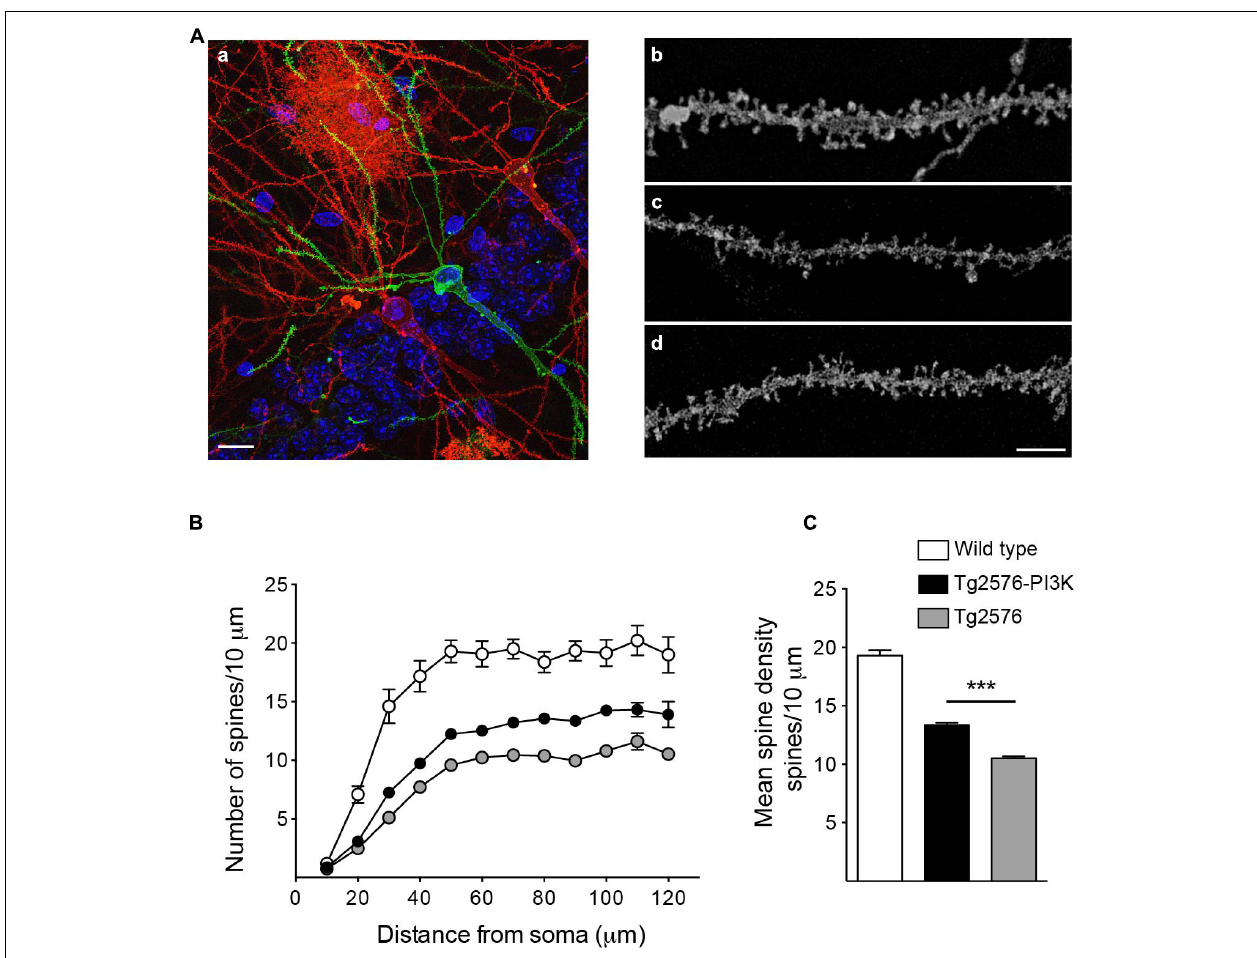
FIGURE 9 | PI3K increases spine density in aTg2576 mice model. ( A) (a) Example of biolistic stain, the image shows an area from the basal CA1 region of a 6-month-old Tg2576 mouse.Three hippocampal neurons appear stained with DiI (red) or DiO (green). The stratum pyramidale nuclei appear in blue (DAPI). An astrocyte, red area in the top middle side of the picture was also labeled. Scale bar: 10 μ m (a). Representative dendritic segments for Wild-type (b), Tg2576 (c), and Tg2576 injected with PTD4-PI3KAc (d). Scale bar = 3 μ m. (B) Number of spines along basal dendrites in neurons from wild-type (open circles), Tg2576 (gray circles), and PTD4-PI3KAc-treated Tg2576 mice (closed circles). The values were